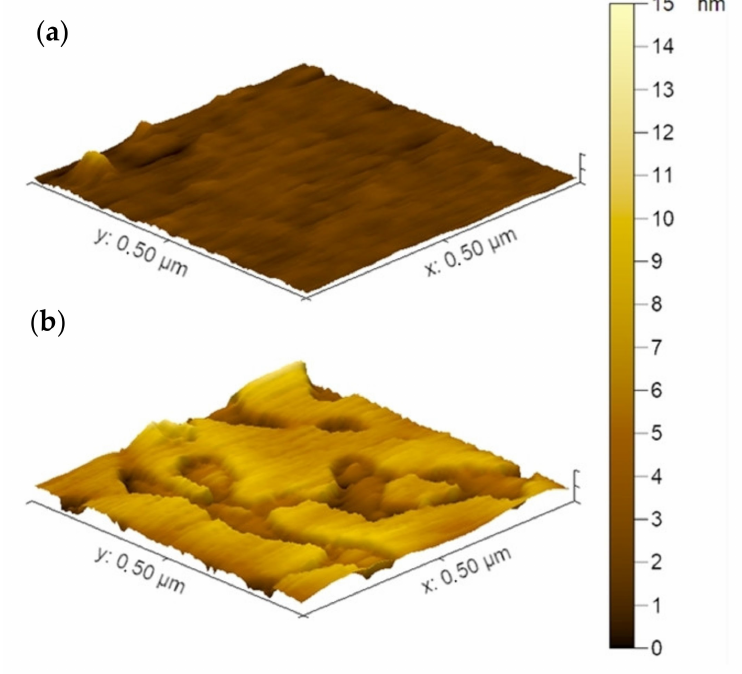
Figure 9. AFM images of coatings from IPEC with χ = 0.06 on the glass ( a ) and PVC ( b )